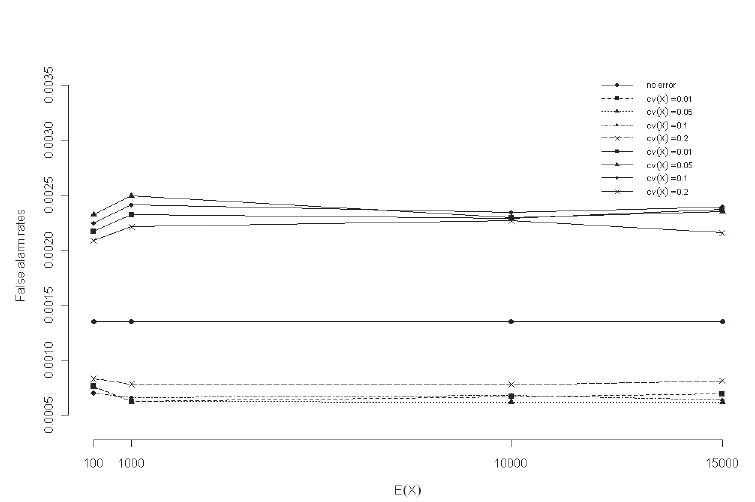
Figure 1 – False alarm rates from 10 8 replications (dotted lines for the values below the LCL , con- tinuous lines for the values above the UCL